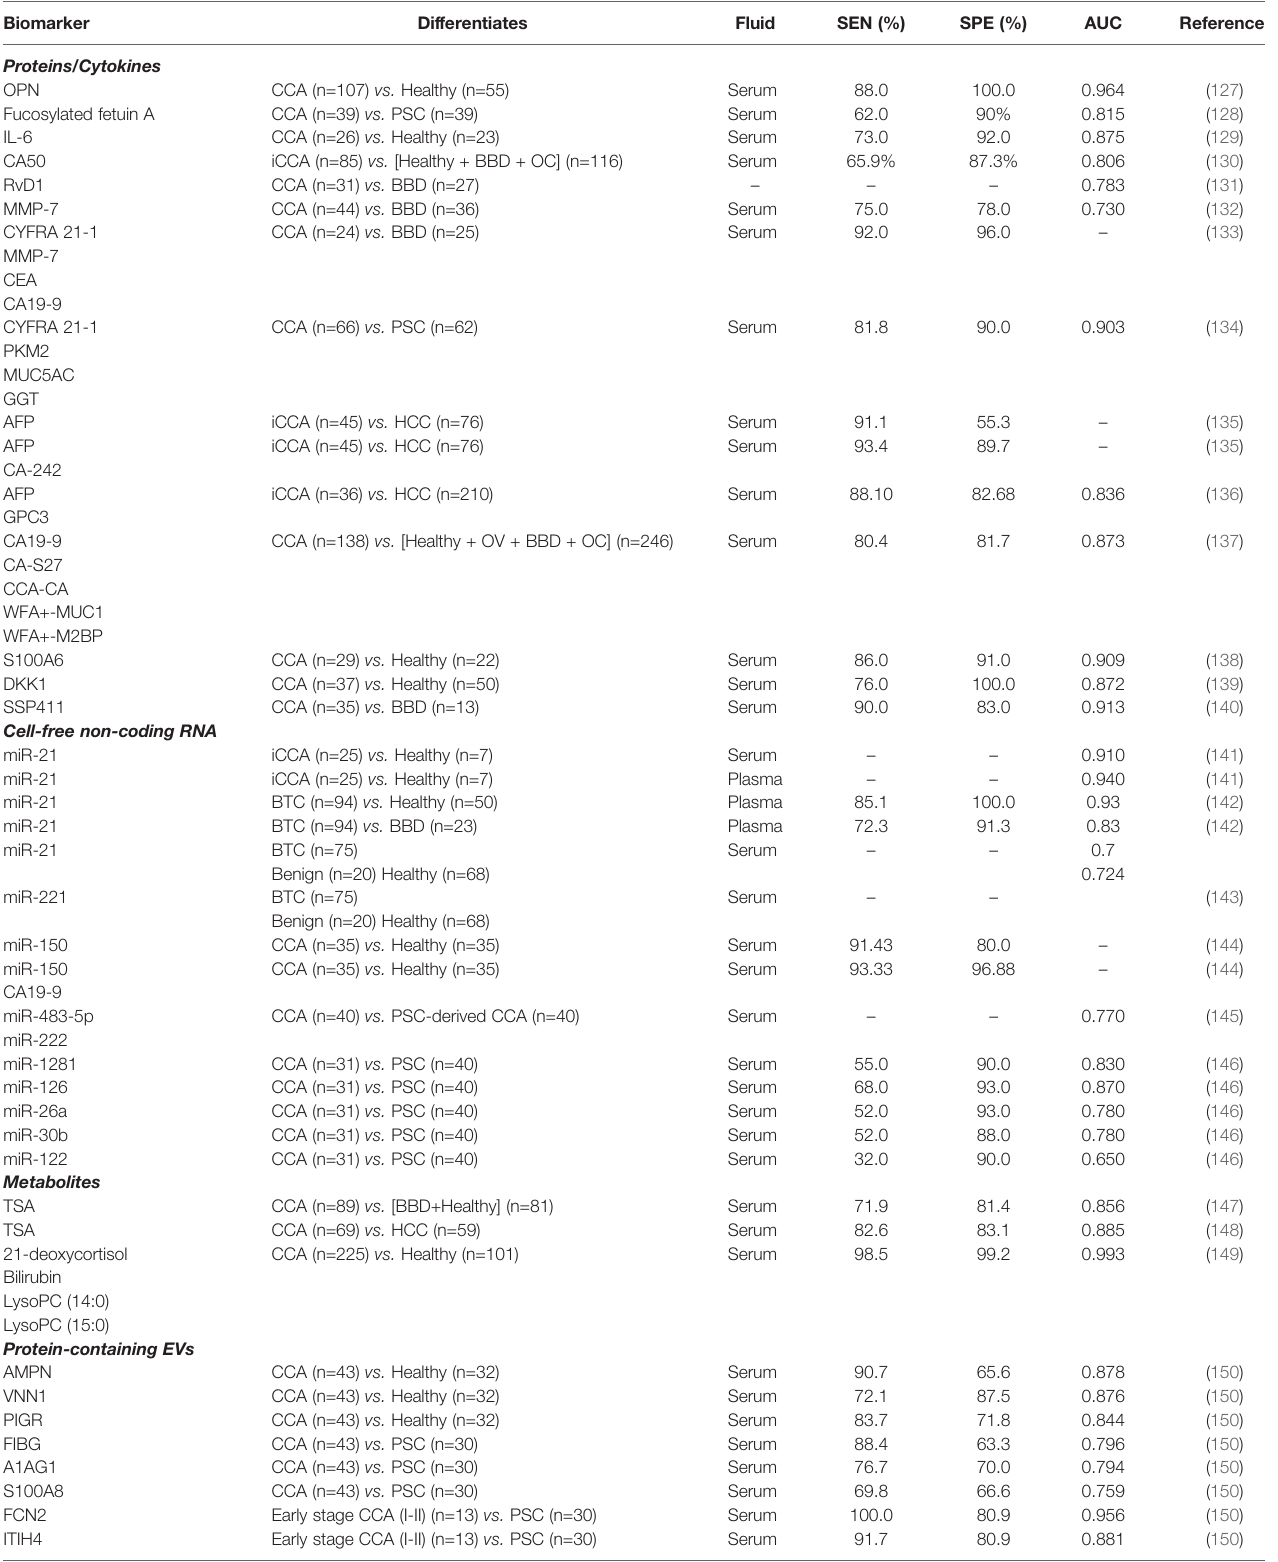
TABLE 3 | Blood (serum, plasma) biomarkers.